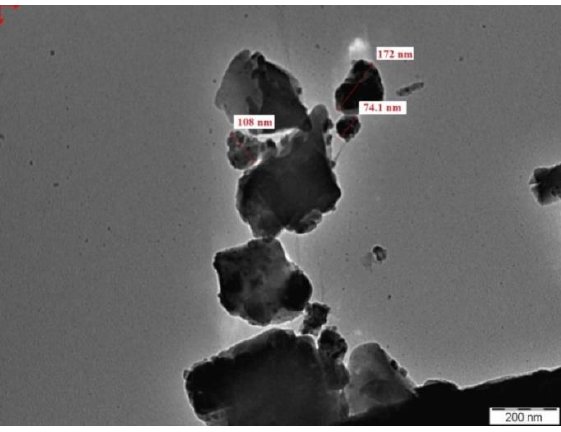
Figure 3. TEM image of BGWNP .